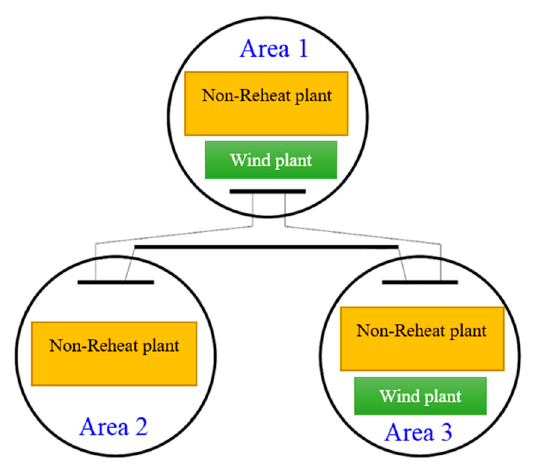
Figure 1. A simplified sketch of a three-area integrated wind plant system.